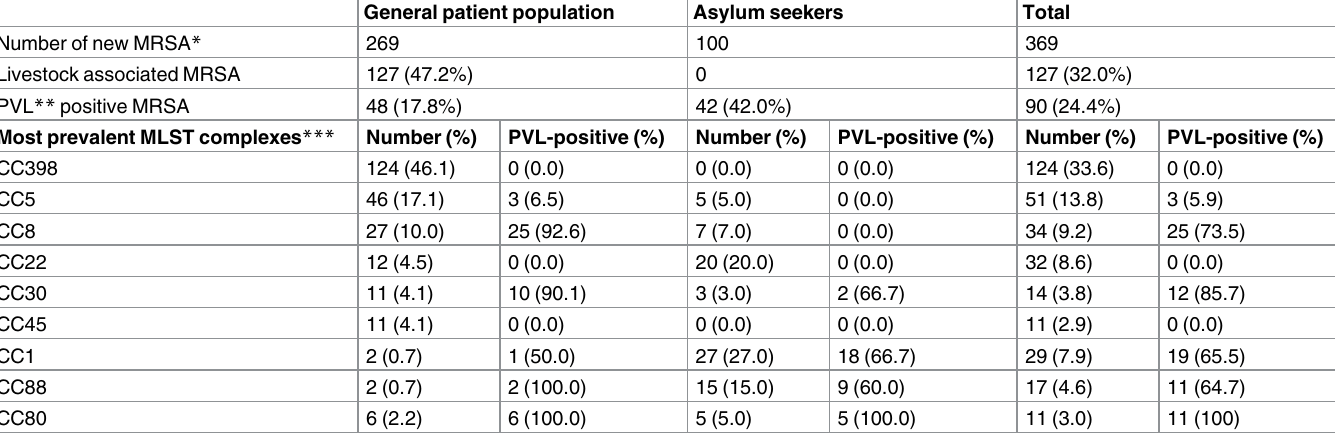
Table 2. Genetic characteristics of MRSA isolates of the general versus the asylum seekerpatient